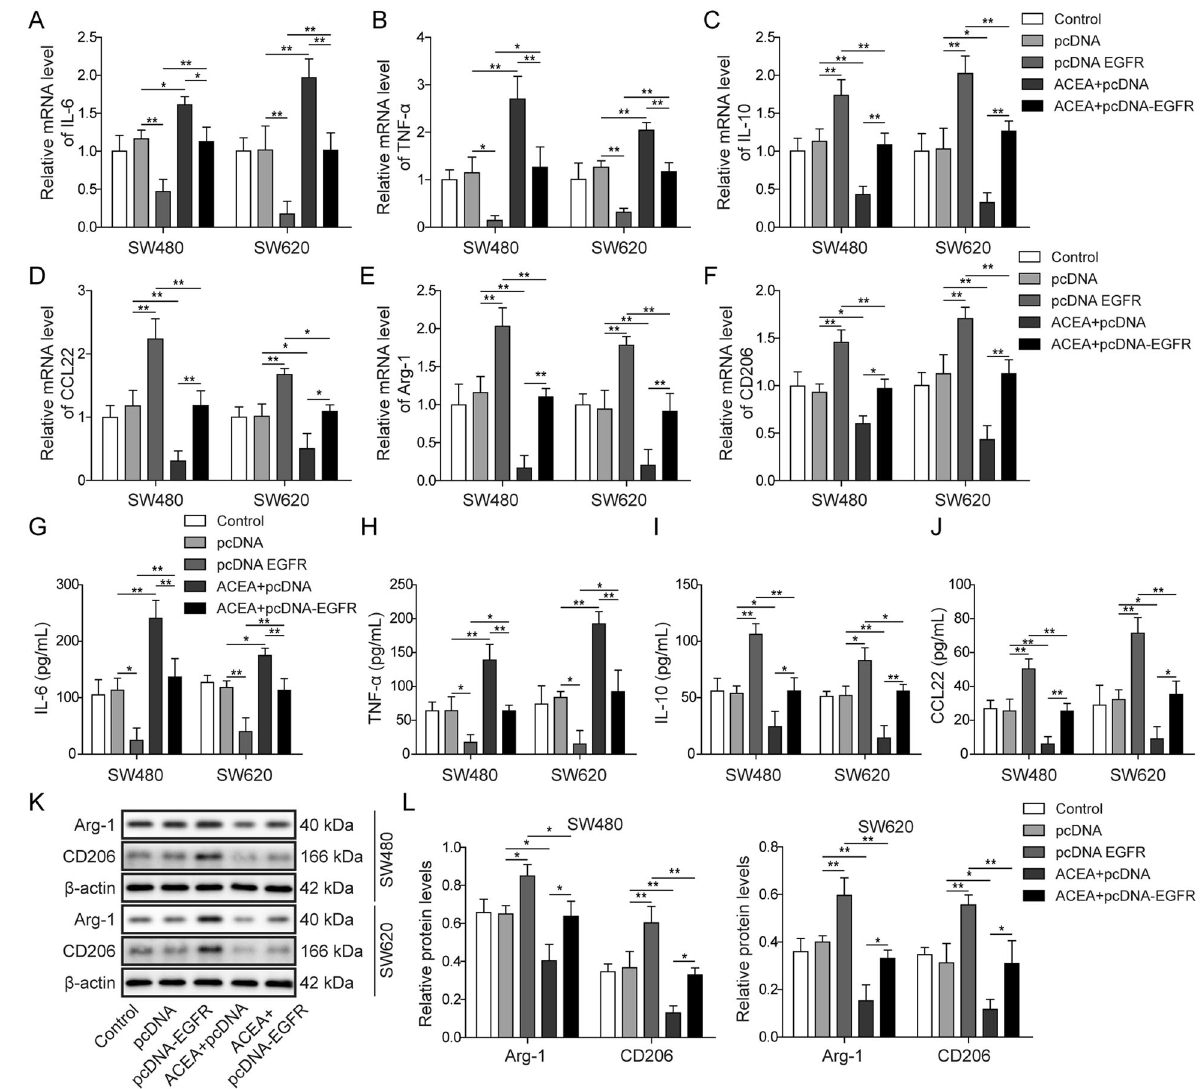
Fig. 5 CB1 activation suppressed M2 macrophage polarization by regulating EGFR. Colorectal cancer cells were transfected with EGFR plasmids and simultaneously treated with ACEA. Then PMA induced THP-1 cells were co-cultured with the culture medium of colorectal cancer cells. A – F QPCR results demonstrated that EGFR overexpression blocked CB1 activation caused increase in the expression of IL-6 and TNF- α , and decrease in IL-10, CCL22, Arg-1 and CD206. G – J ELISA assay showed that EGFR overexpression blocked CB1 activation